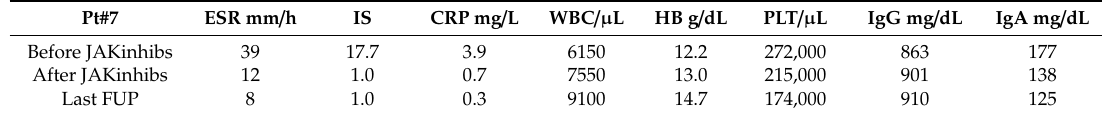
Table A7. Patient #7 laboratory